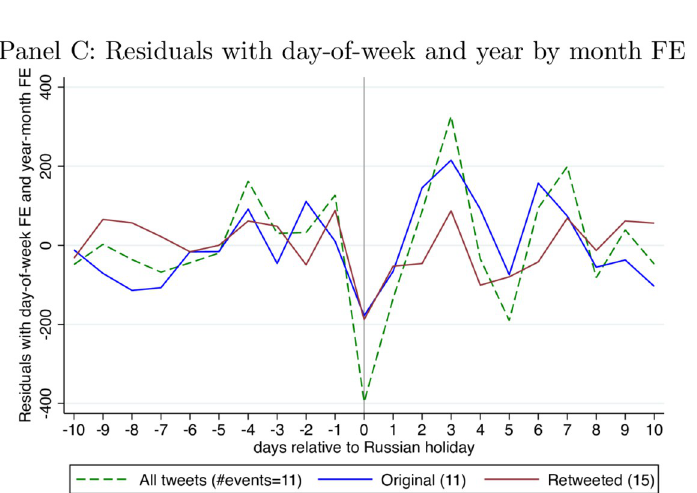
Fig 2. Wave 1 tweets (day shift) around Russian holidays Nov. 2014–Nov. 2016. (Similar to Fig 1, we drop top 10 busiest days for each category (all, original, retweeted tweets) 2012–2017, and only keep holiday events with complete data over the 21-day window. This results in a smaller number of events than 15 (8 events per year over 2 years, minus Unity Day (Nov 4) 2016 with incomplete betting data) and different number of events for each category, reported in parentheses). Panel A: Raw data. Panel B: Residuals with day-of-week FE. Panel C: Residuals with day-of-week and year by month